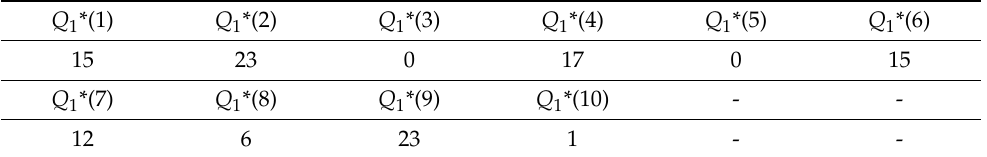
Table 4. Optimal delivery plan for warehouse 1 ( τ * =